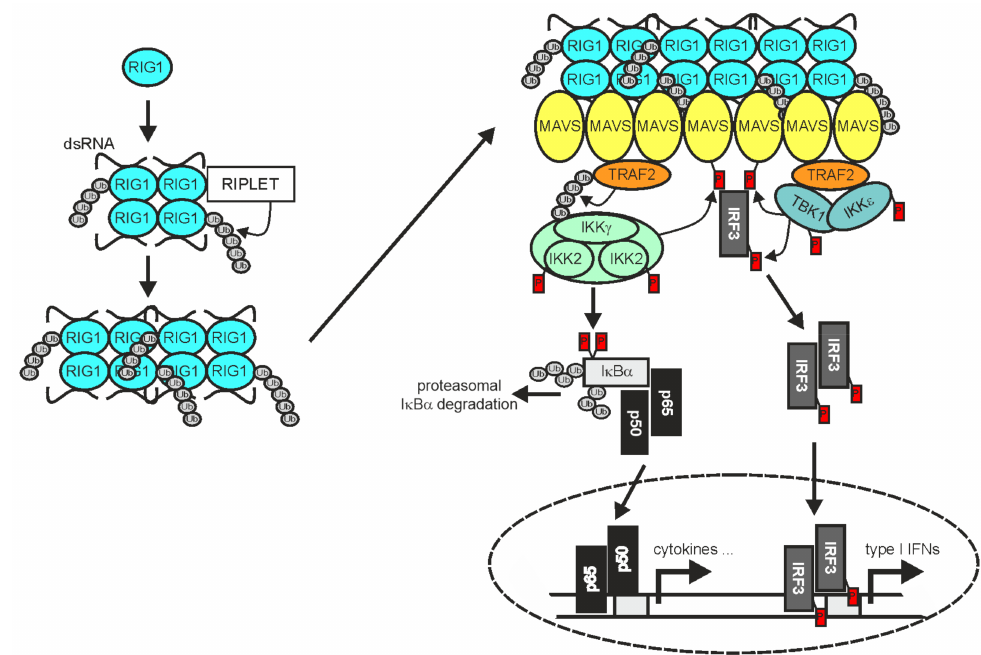
Figure 3. TRAF2 in RIG1 signaling. Binding of dsRNA by RIG1, results in conformational change, K63-ubiquitination, and filament formation. RIG1 filaments in turn instruct filament formation of mitochondria-associated MAVS. The MAVS filaments enable recruitment of TRAF2 and IRF3, but also other TRAF proteins not indicated here. TRAF2 and the other TRAF proteins mediate the recruitment of the IKK complex and TANK-binding kinase 1 (TBK1)/IKK ε enabling activation of the classical NF κ B pathway and IRF3 by the mechanisms described in detail in the text. Please note, TRAF2 acts independently here from cIAP1 and cIAP2 [74]. For more details refer to main